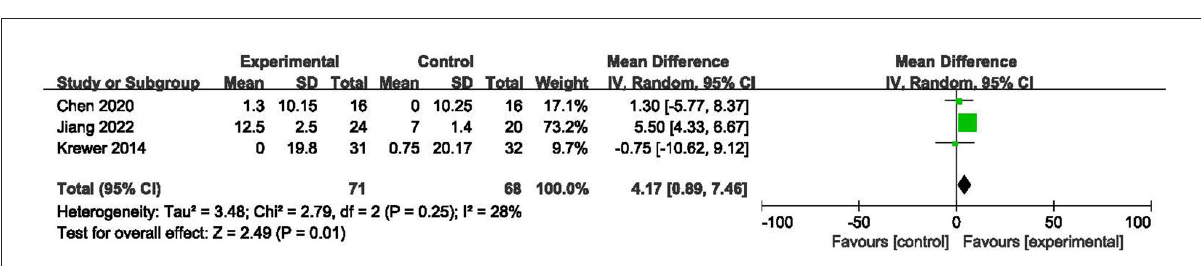
FIGURE6 Meta-analysis of the effect of rPMS on motor function measured with Fugl-Meyer